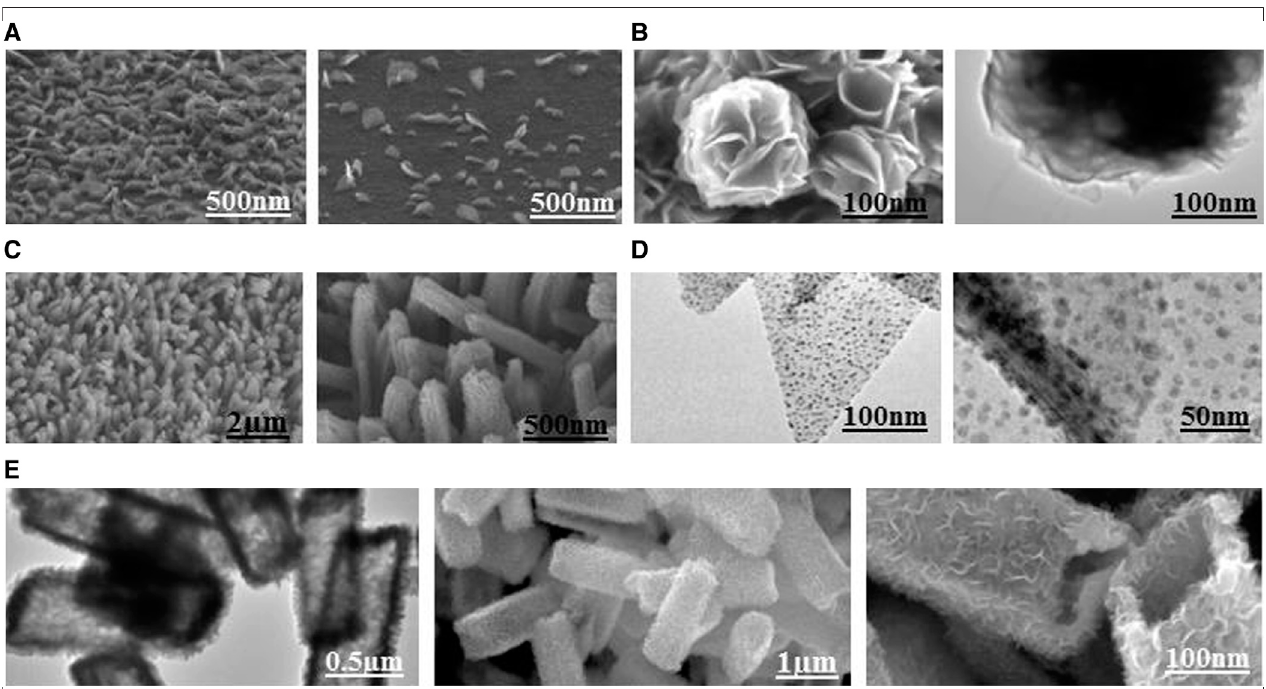
FIGURE 1 | MoS 2 with different hierarchical structures: (A) Vertical nano fl akes. Reprinted with permission from Kang et al. (2017). Copyright (2017) American Chemical Society. (B) Flower-like spheres. Reprinted with permission from Tu et al. (2019). Copyright (2019) American Chemical Society. (C) Nanorods. Reprinted with permission from Sun et al. (2018). Copyright (2018) American Chemical Society. (D) Porous fi lm. Reprinted with permission from Li et al. (2019). Copyright (2019) American Chemical Society. (E) Porous hollow rhomboids. Reprinted with permission from Han et al. (2020). Copyright (2020) American Chemical